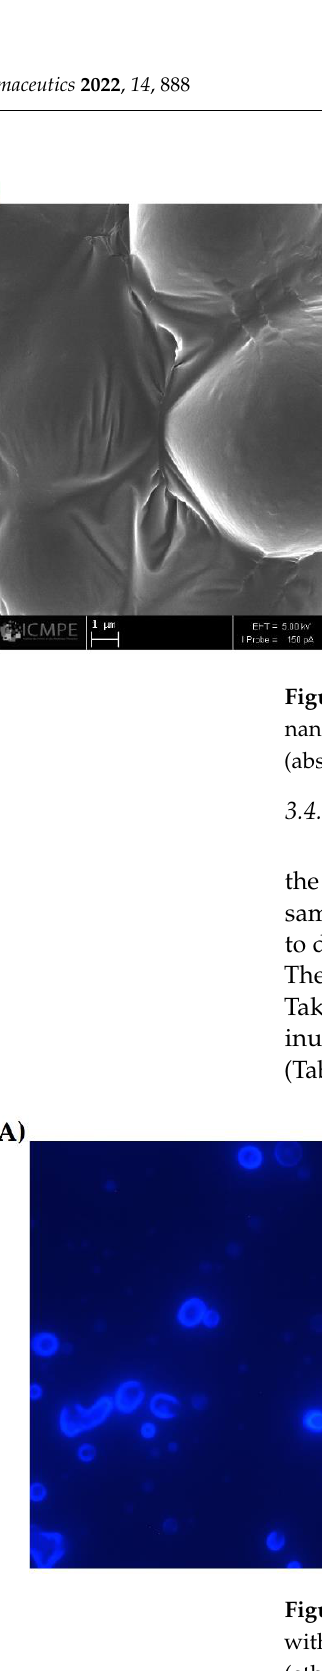
Figure 5. Size characterization of nanoparticles loaded with quercetin. ( A ) SEM image of inulin na- noparticles loaded with quercetin (NQs) (5000× magnification, scale 3 µm). ( B ) DLS NQs reconsti- tuted in organic solvent (absolute ethanol).